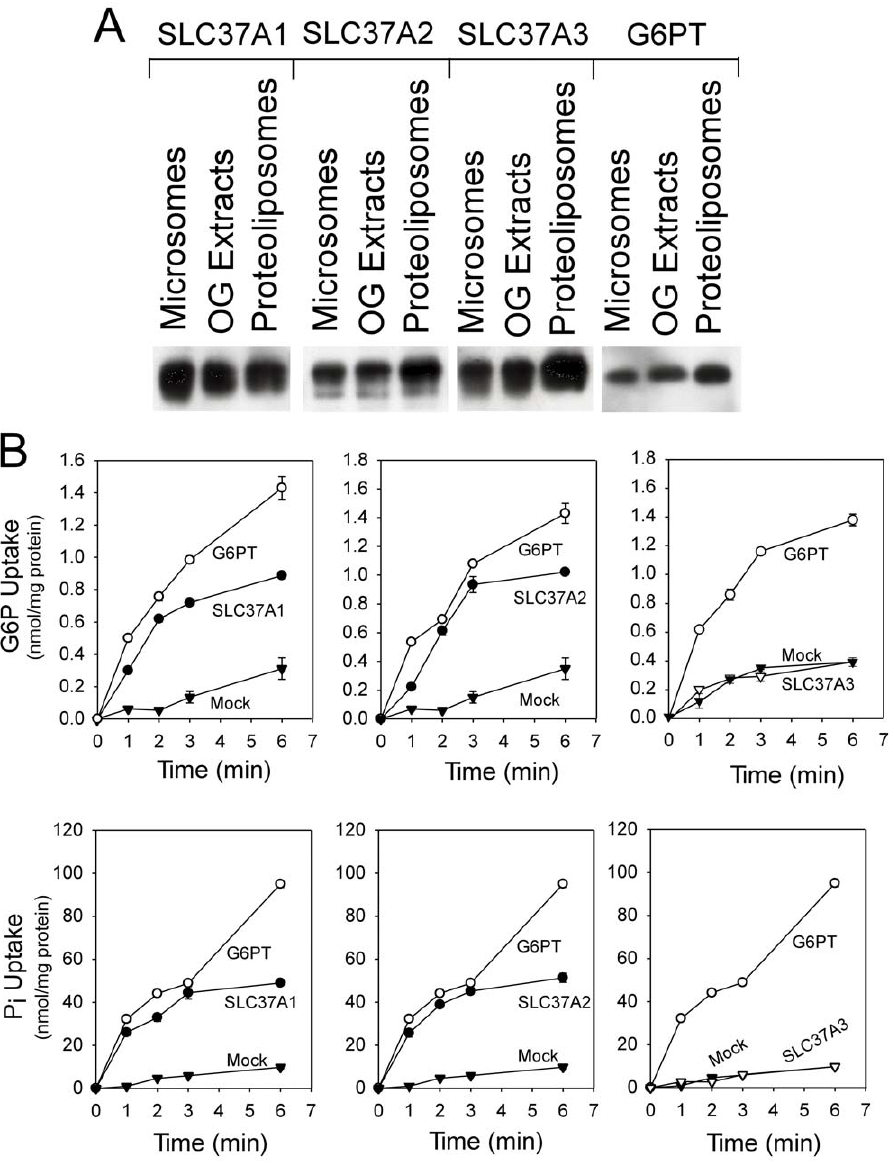
Figure 2. G6P and P i uptake in SLC37 proteoliposomes. Microsomes were isolated from COS-1 cells infected with Ad-SLC37A1-5Flag, Ad- SLC37A2-5Flag, Ad-SLC37A3-5Flag or Ad-G6PT and proteoliposomes were reconstituted from the respective detergent solubilized microsomal membrane extracts as described under Materials and Methods. Results shown are from three independent experiments, each point determined in triplicate. (A) Western-blot analysis of SLC37 proteins during reconstitution of proteoliposomes from the respective microsomal membranes using a mouse monoclonal antibody against the Flag epitope or a rabbit polyclonal antibody against G6PT [12]. Each lane contains 10 m g protein. (B) G6P or P i uptake in 50 mM P i -loaded SLC37A1-, SLC37A2-, SLC37A3-proteoliposomes. G6P or P i uptake in 50 mM P i -loaded G6PT- and mock- proteoliposomes were used as